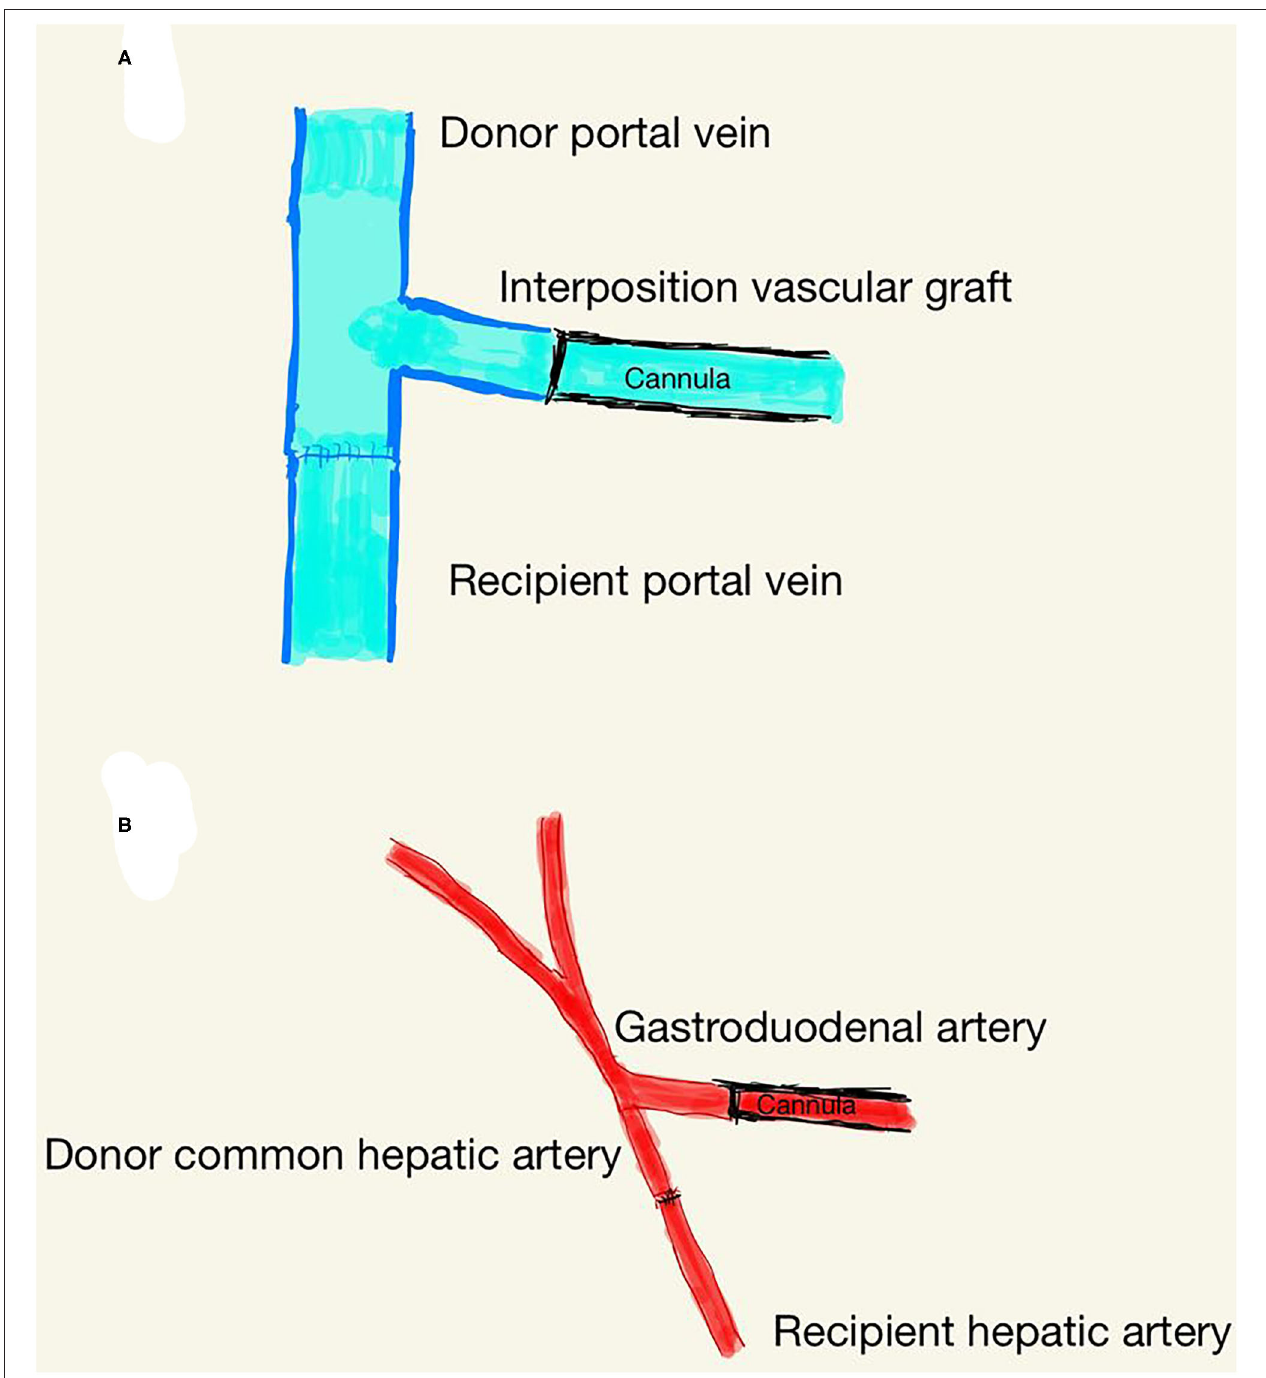
FIGURE 1 | Schematic diagram of portal vein (A) and hepatic artery (B) anastomosis.